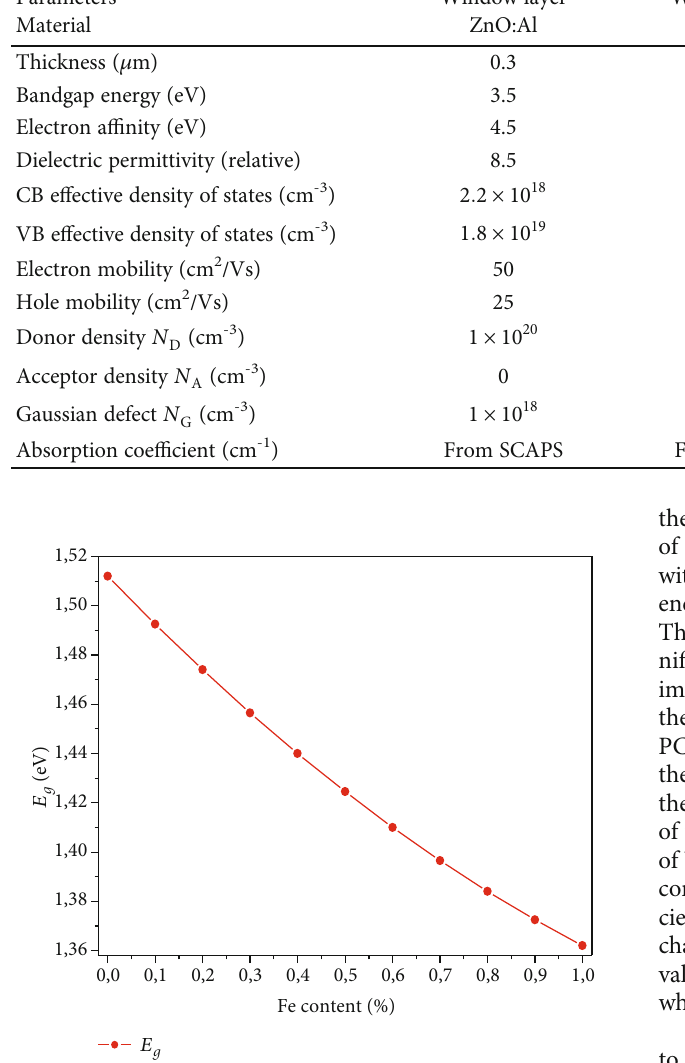
Figure 2: The plot of the variation of the bandgap with increasing Fe